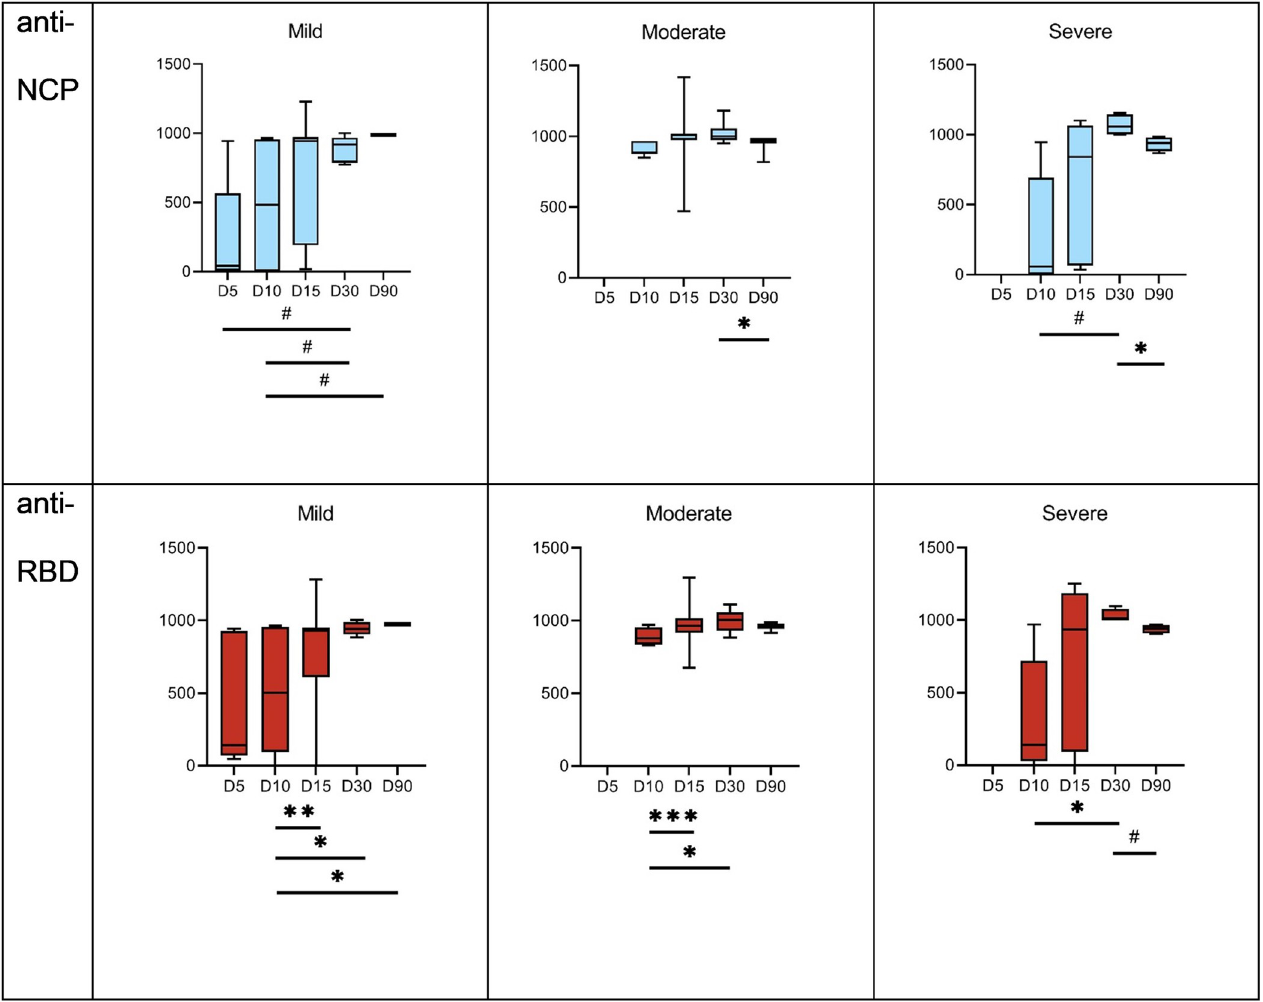
Fig 3. Kinetics of induction of SARS-CoV-2-specific IgG in hospitalized COVID-19 patients; anti-NCP IgG- fraction of IgG specific to nucleocapsid protein of SARS-CoV-2, anti-RBD IgG- fraction of IgG specific to receptor binding protein of SARS-CoV-2, mild–patients treated without assisted respiratory therapy, moderate–patients with limited support of non-invasive assisted respiratory therapy (mask), severe/critical–patients with intensive non-invasive assisted respiratory therapy or invasive mechanical ventilation, D5-D90—days from 5 to 90 representing estimated number of days after onset of infection. Antibodies were identified in blood samples after separation of blood sera by clotting and centrifugation. Microblot-Array testing was applied to quantify IgG level (U/ml). T-test between each time point sample for anti-NCP and anti-RBD IgG titers was applied, #– 0.1 < p < 0.5; � –p < 0.05; �� – p < 0.01; ��� – p <